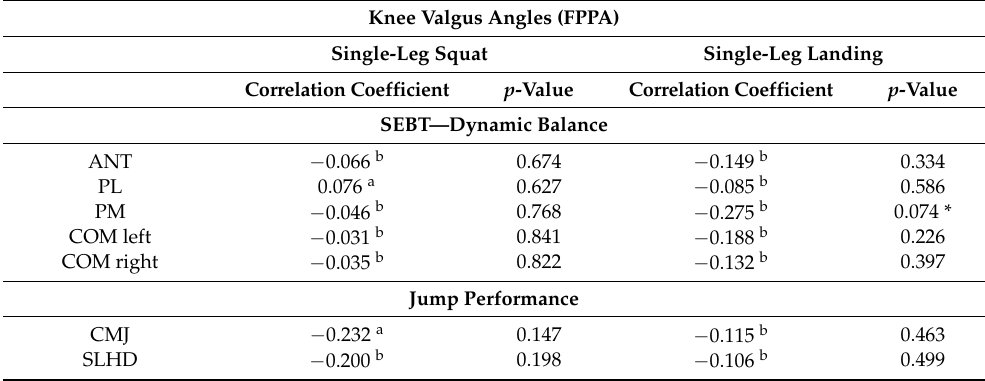
Table 4. Correlations between the mSEBT, jump performance, functional movement screen, and dynamic knee